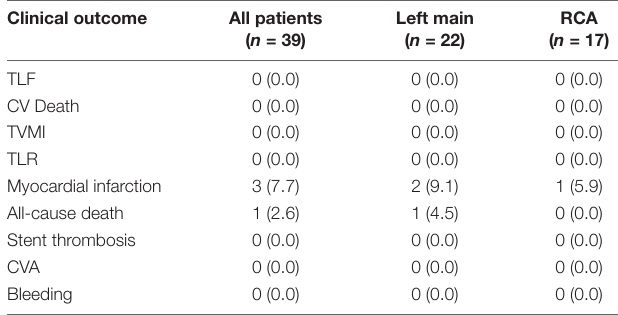
TABLE 3 | Procedural characteristics: geographic miss and intravascular ultrasound findings.